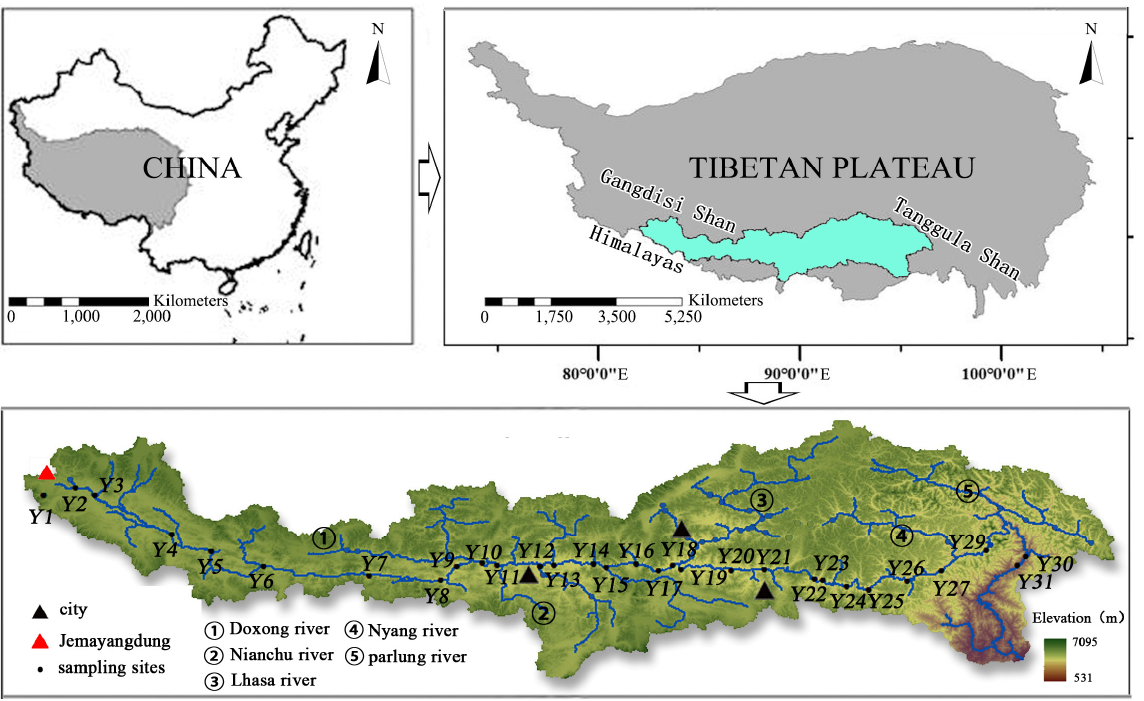
Figure 1. The Yarlung Tsangpo basin in the Tibetan Plateau and a sampling point distribution diagram. Black circles and letters indicate sampling sites that correspond with figures and elsewhere in this study. Black triangles refer to major cities, red triangle refers to Jemayangdung. Y1–Y31 represents the sampling point location.